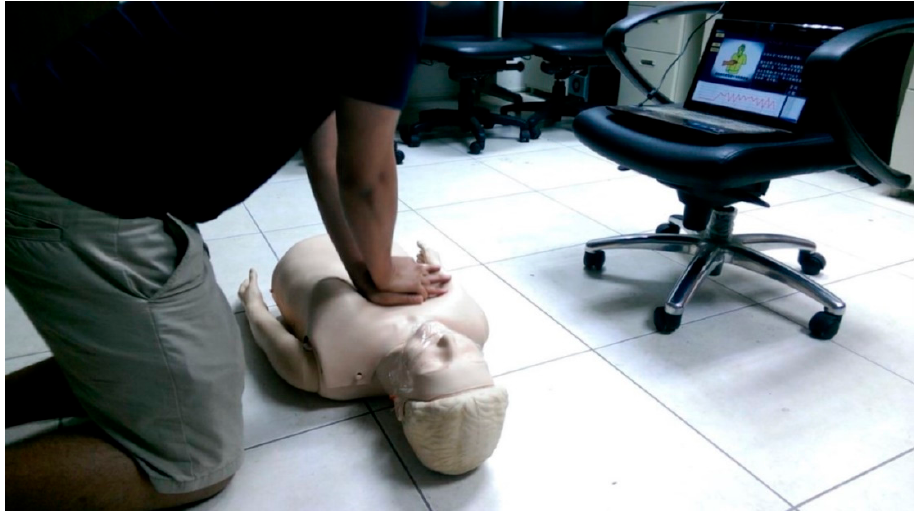
Figure 9. The interactive CPR tutoring software schematic.